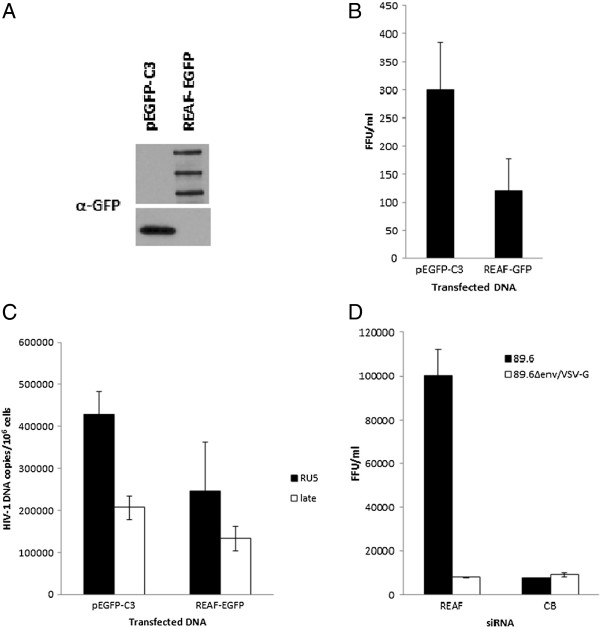
Over-expression of REAF confers restriction which is viral route of entry dependent. (A) Over-expression of REAF restricts early HIV-1 DNA production. HEK 293 T cells were transiently transfected with pEGFP-C3 or REAF-EGFP and the Western blot probed with α-GFP antibody. Transfection of REAF-EGFP results in expression of REAF (110, 160 and 250 kDa including EGFP tag (30 kDa). Endogenous REAF was knocked out of HeLa-CD4 cells using siRNA targeting its 3’ UTR. (B) Infected cells were measured following transient over-expression of REAF-EGFP or pEGFP-C3 and challenge with HIV-189.6. Results are shown as FFU/ml and are mean ± s.d. of a representative experiment performed in duplicate. (C) Transient over-expression of REAF-EGFP in HeLa-CD4 cells results in decreased RU5 and late RT products 8 hr post challenge with HIV-189.6. HIV-1 DNA copies are normalised to genomic GAPDH and presented per million cells. Results are mean ± s.d. of a representative experiment performed in duplicate. (D) Restriction by REAF is dependent upon viral route of entry. HIV-189.6Δenv was pseudotyped with VSV-G envelope and used to challenge HeLa-CD4 cells following REAF siRNA knockdown. p24 immunostaining was used to detect FFU compared with HIV-189.6. Results are shown as FFU/ml and are mean ± s.d. of a representative experiment performed in duplicate.